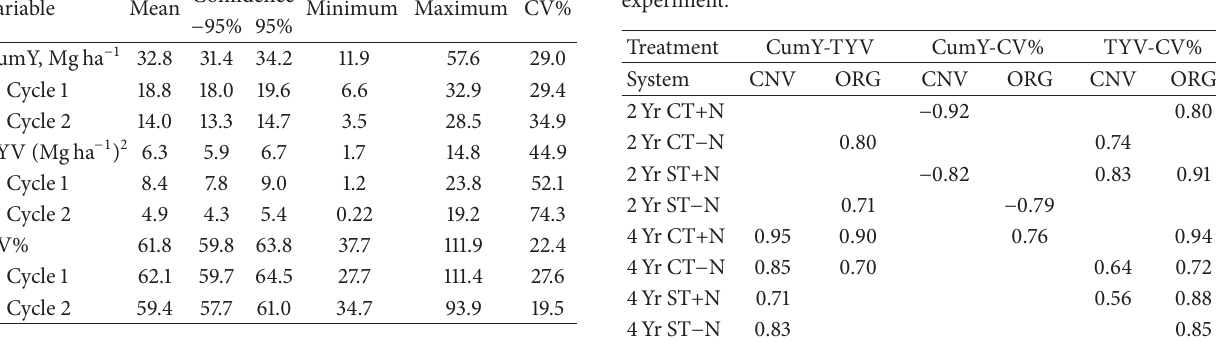
Table 4: Significant ( P < 0.05) correlation coefficients between cumulative yield, CumY, temporal yield variance, TYV, and coeffi- cient of variation, CV%, for 16 treatment combinations in conven- tional (CNV) and organic (ORG) cropping systems of a long-term